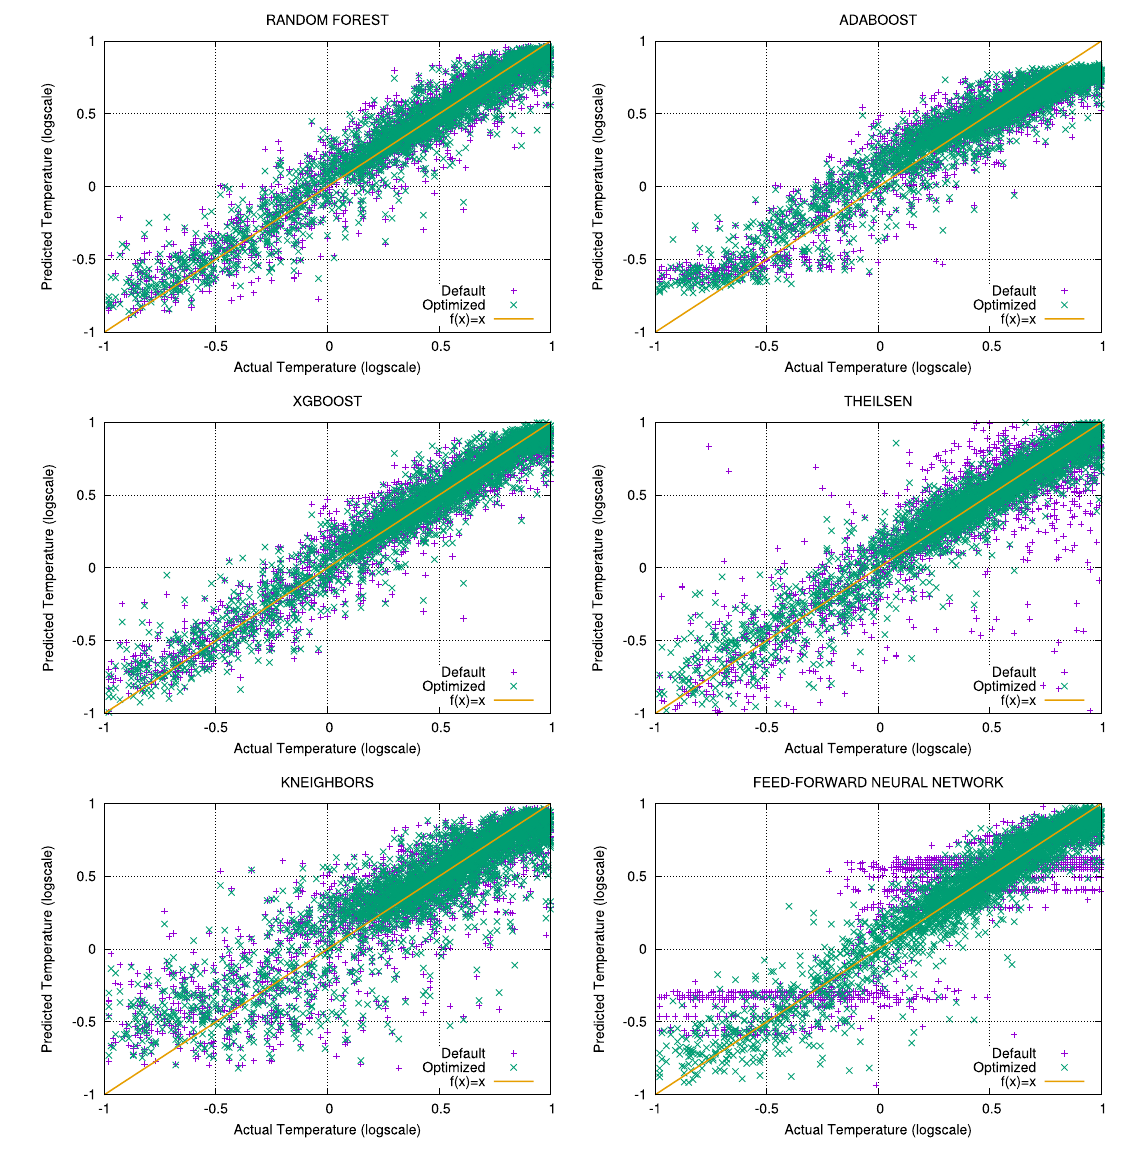
Fig. 3 Predicted temperature versus actual temperature, for some regression techniques with a small standard deviation